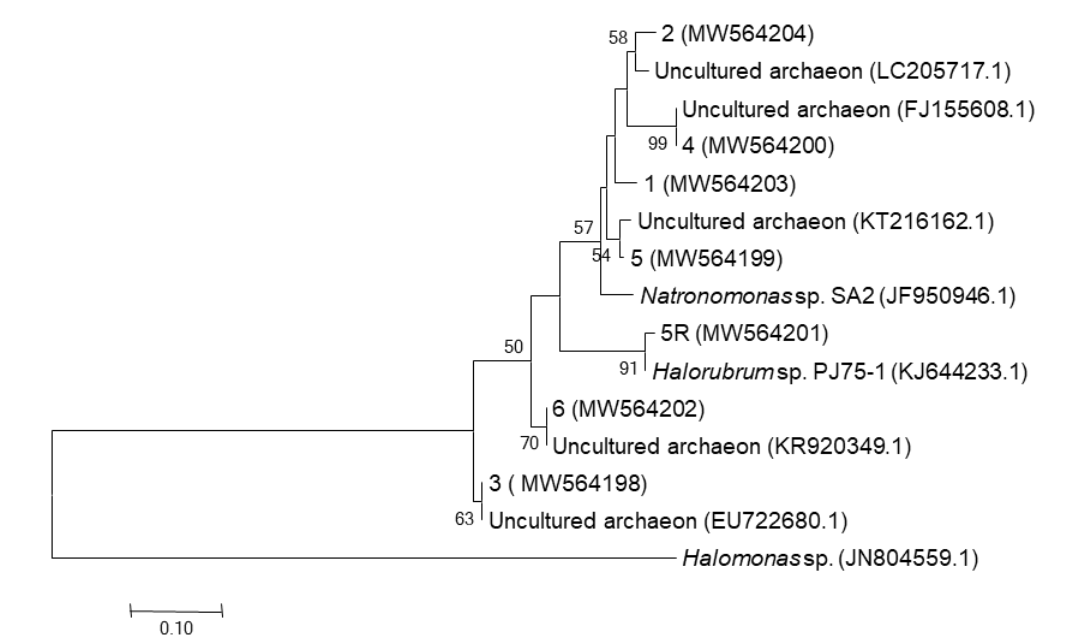
Figure 3. Maximum likelihood phylogenetic tree inferred from 16S rRNA gene sequences of DGGE bands and their closest relatives retrieved from RDPII database. Tree topology was build using the neighbor_joining method using MEGA 6.0. Bootstrap values ( n = 1000 replicates) were indicated at the nodes. Scale bar represents 5% sequence difference. Halomonas sp. (JN804559.1) was used as the outgroup to define the root of the tree. Accession number of sequences are shown in parenthesis.